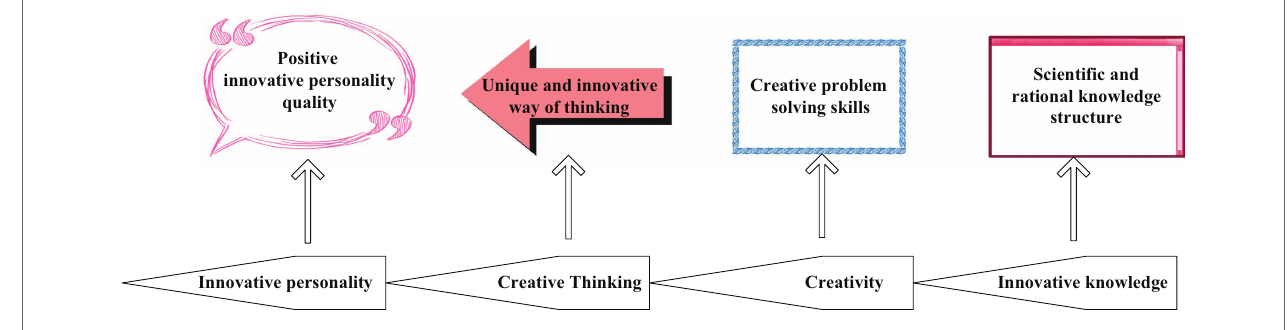
FIGURE 3 | Four elements of personality